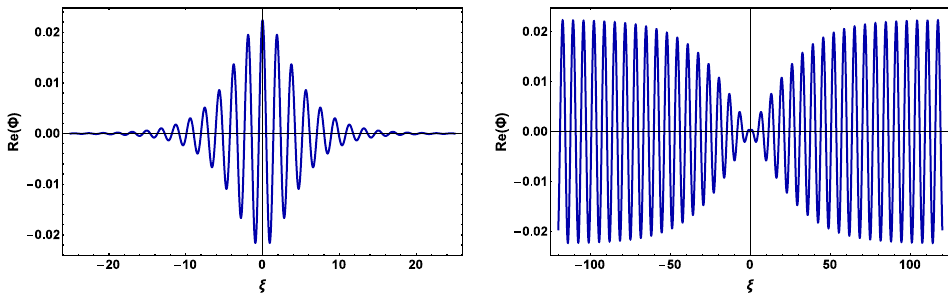
Figure 1. The bright (left panel) and dark (right panel) envelope solitons for k = 1.6 and k = 1.2, respectively, along with η = 0.07, ρ = 1.2, (cid:36) = 1.5, κ = 2, µ 1 = 0.8, µ 2 = 0.3, τ = 0, ψ 0 = 0.0005, U = 0.2, and Ω 0 =